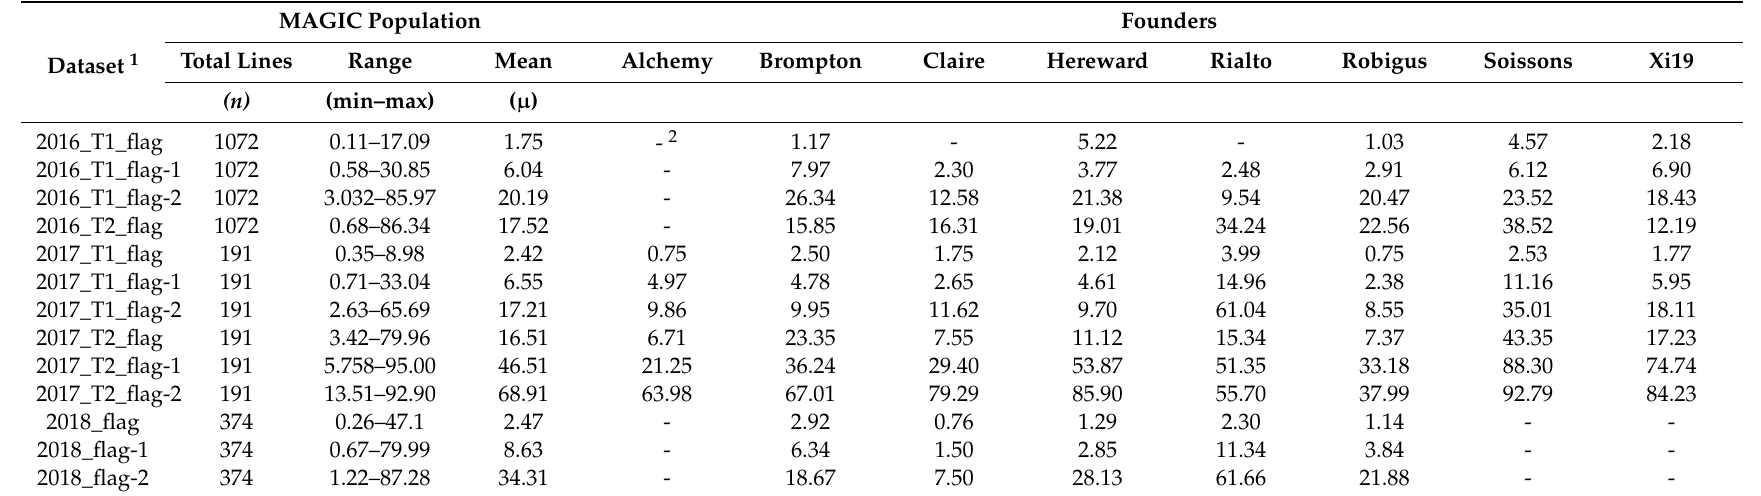
Table 4. Summary of percentage septoria tritici blotch (STB) infection in the MAGIC population, along with STB scores for the eight founders across all datasets. The adjusted means were logit (p) back-transformed to a 0–100 percentage scale. The data shown includes the total number of lines, range, and population mean in each dataset along with the mean disease severity (%) of the founder in each